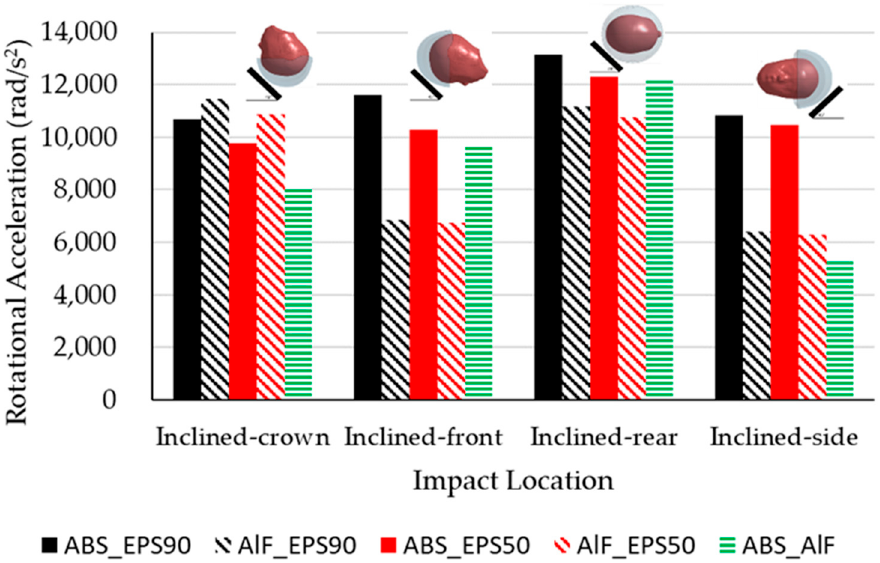
Figure 12. Comparisons of the peak rotational acceleration obtained from the inclined anvil drop test for five combinations of helmet material.